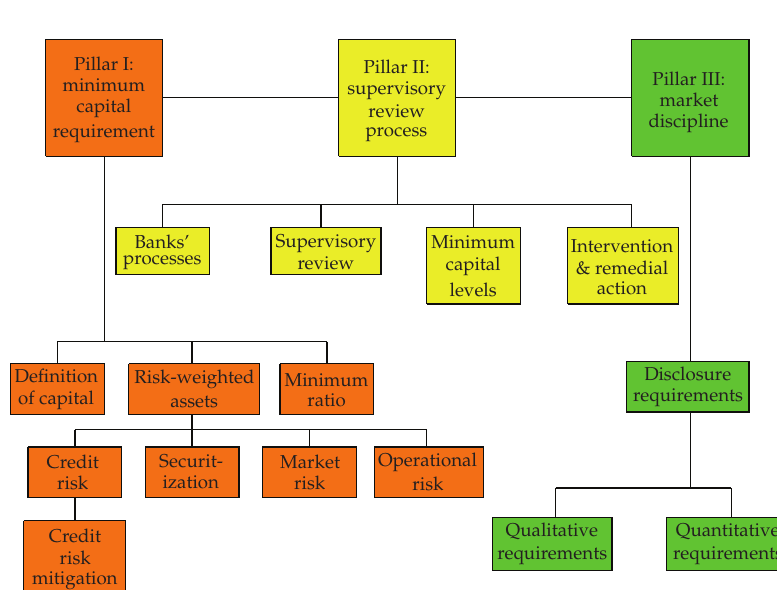
Figure 7: Diagrammatic overview of the Basel II Capital